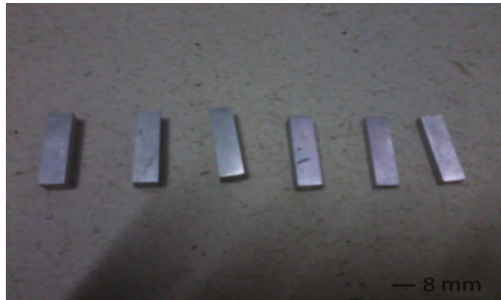
Figure 1: Prepared samples for EN-coatings.